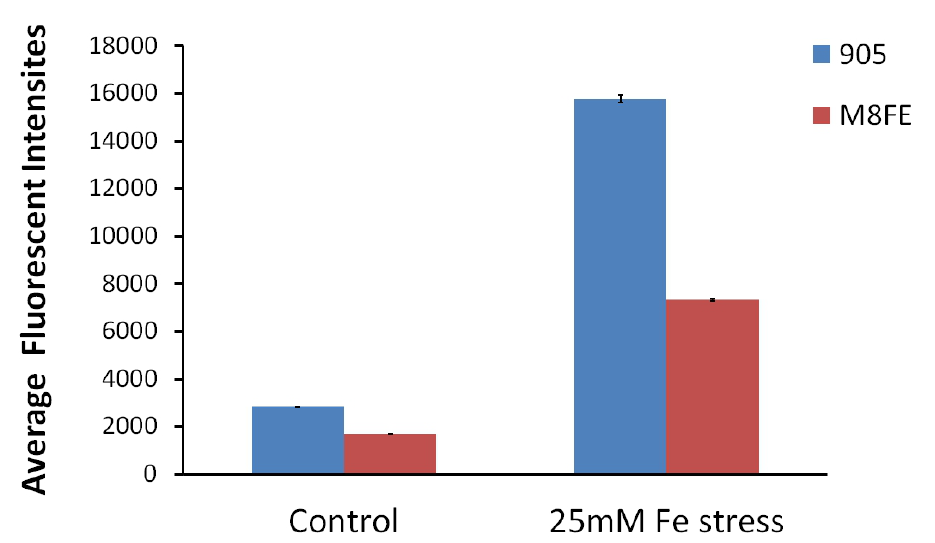
Figure 6. Fluorescent intensity values that indicate the ROS amounts of M8FE and 905 under control and iron stress conditions.